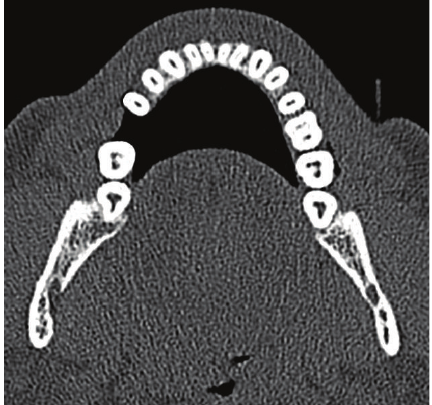
Figure 2: C-shaped canal in mandibular left second